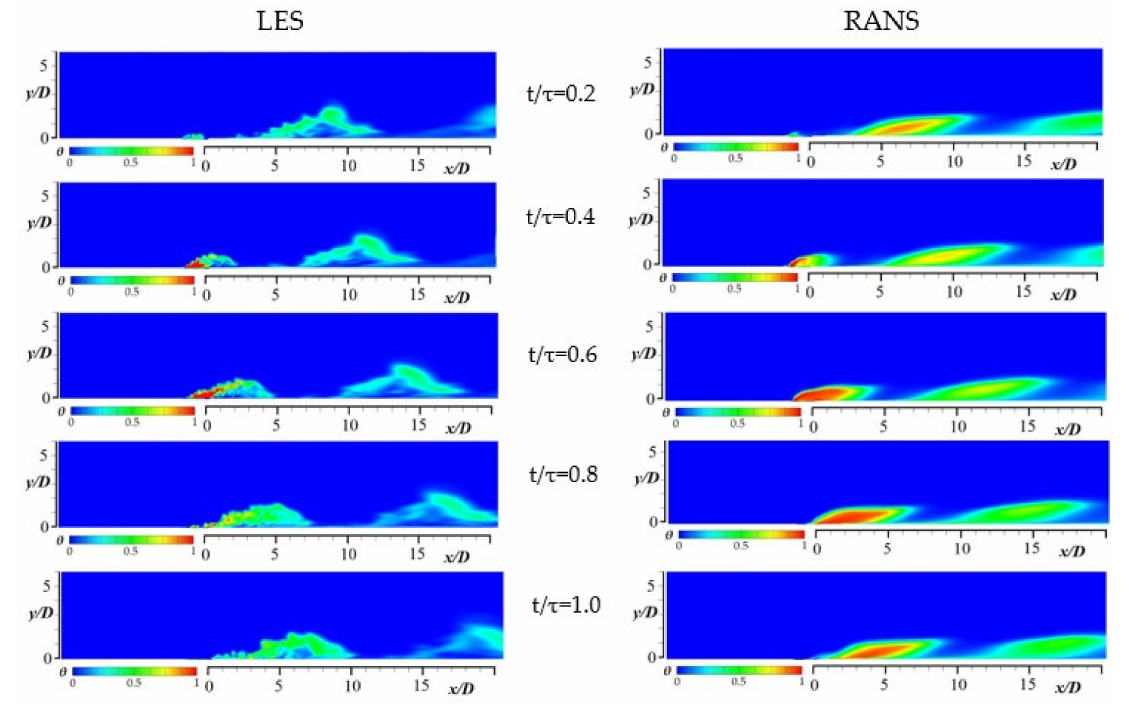
Figure 11. Instantaneous dimensionless temperature contours for the 0 ◦ orientation angle on the spanwise-normal plane of z/D = 0 for the 36 Hz flow pulsation.